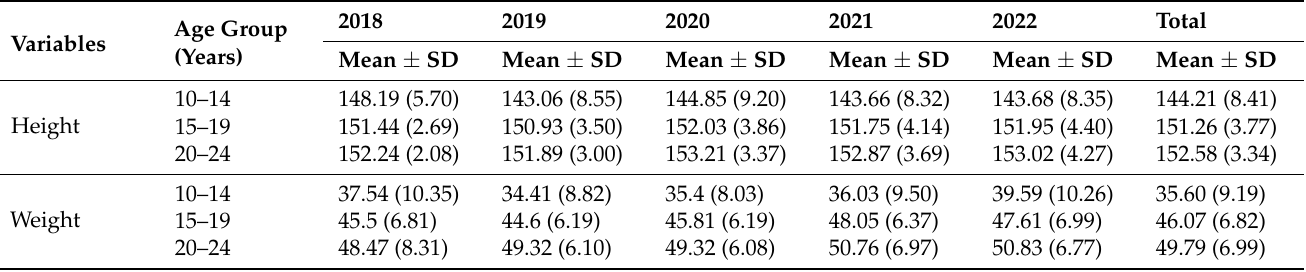
Table 2. Physiological and anthropometric characteristics of the beneficiaries ( n =